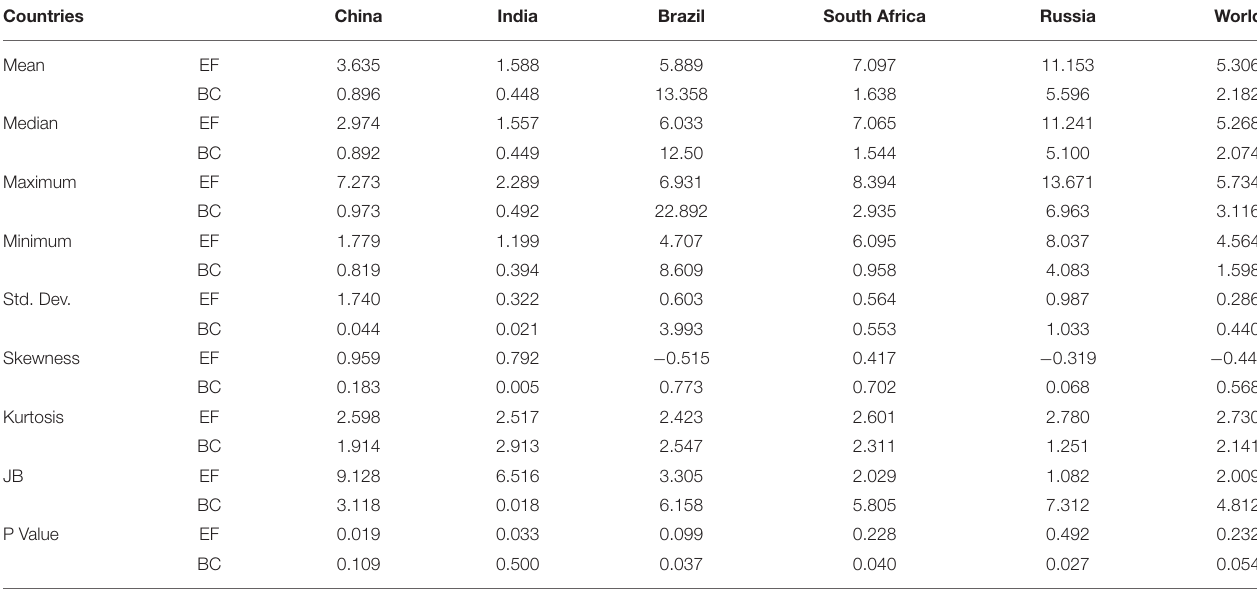
TABLE 1 | Summary statistics of per capita environmental indicators in BRICS and the world.